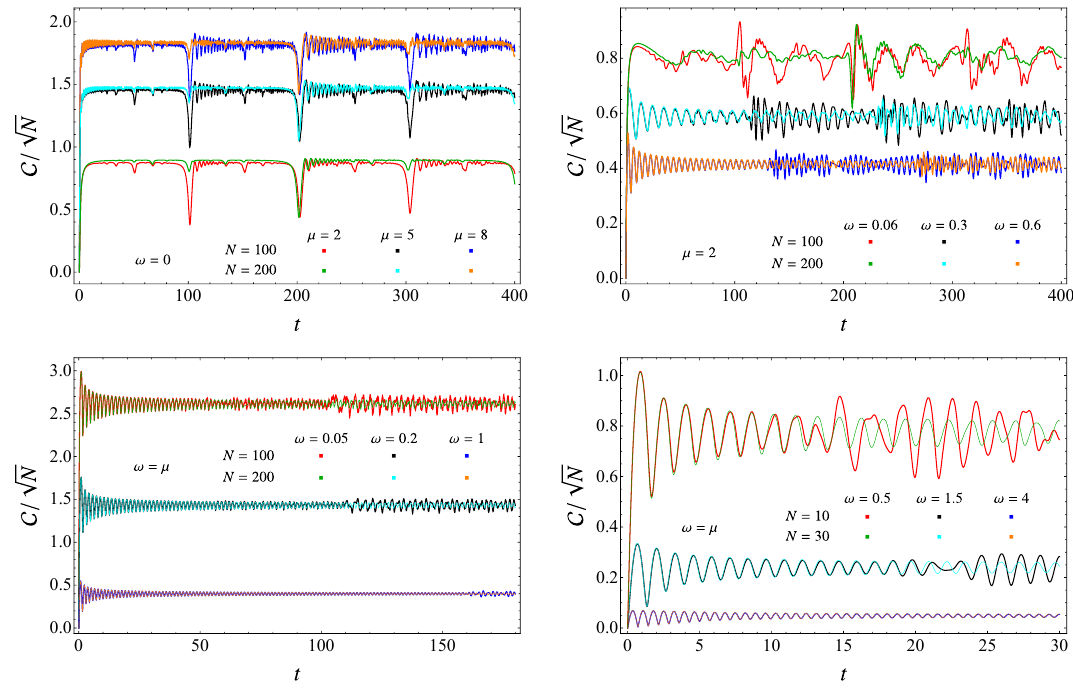
Figure 15 . Temporal evolution of the complexity (A.9) for the entire chain after the global quench of the frequency and of the spring constant. The expression for C in (A.11) has been used respectively in the top and in the bottom